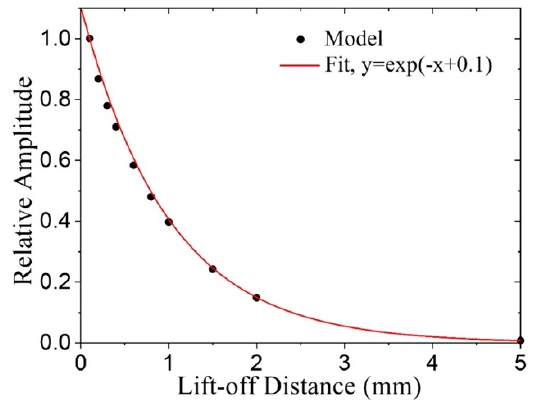
Figure 7. SH0 wave amplitude as a function of coil lift-off.